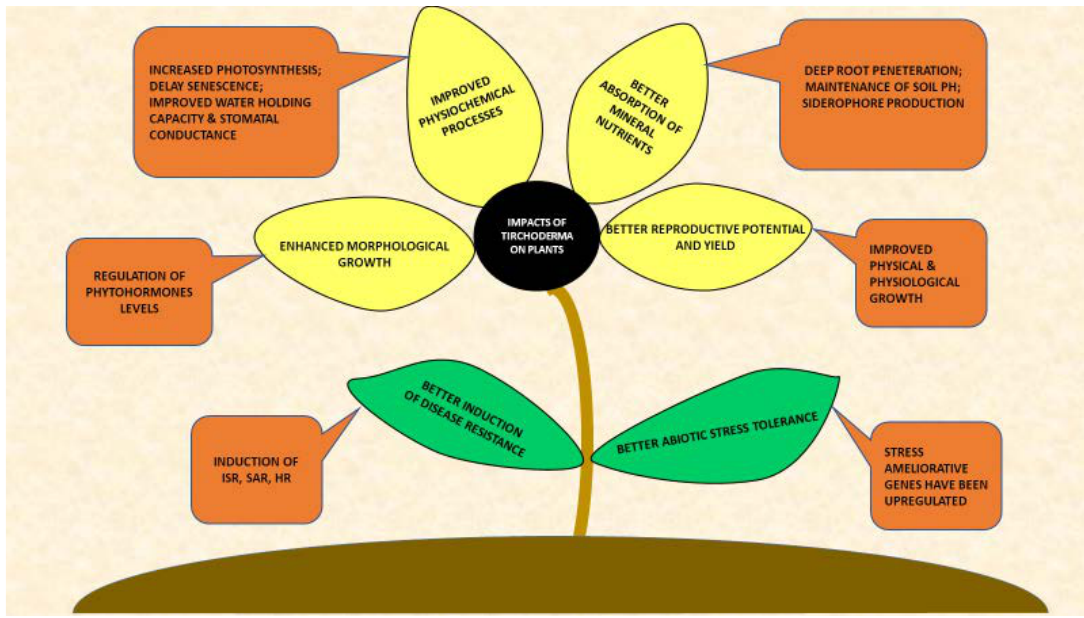
Figure 1. Depicts pictorially the impacts of Trichoderma spp. on plants in rhizosphere. Presence of Trichoderma improved the plant growth and development at physiological and biochemical levels. Further, Trichoderma spp. raised the plant resistance towards several biotic as well as abiotic stresses through multiple adaptive mechanisms.